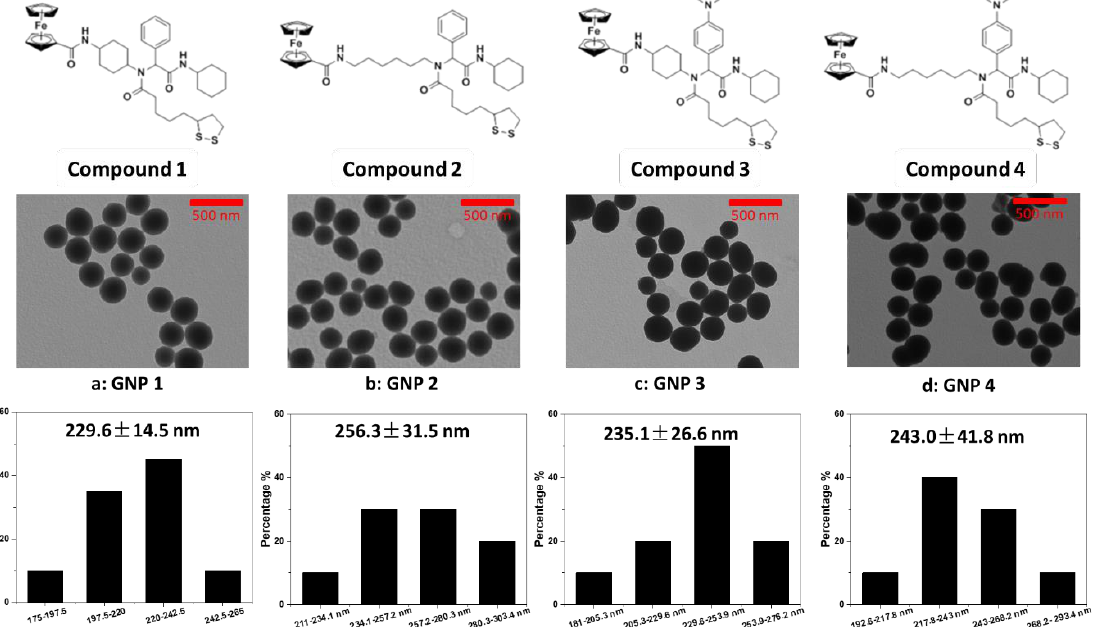
Table 1. Hydrodynamic diameter and zeta potential of GNPs 1–4.